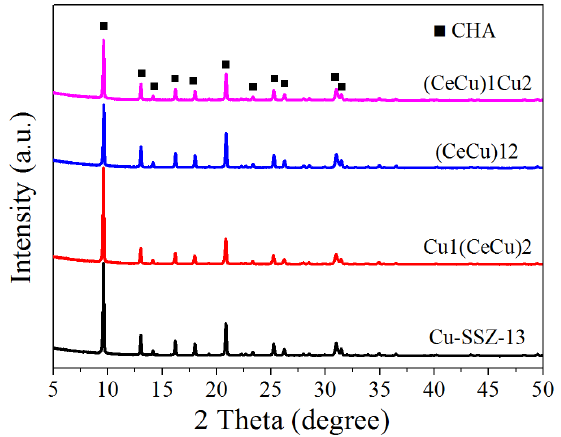
Figure 2. XRD profiles of Cu-SSZ-13 and Ce-modified Cu-SSZ-13 catalysts. Table 1. Elemental compositions and textural properties over Cu-SSZ-13 and Ce-modified Cu-SSZ-13 catalysts.